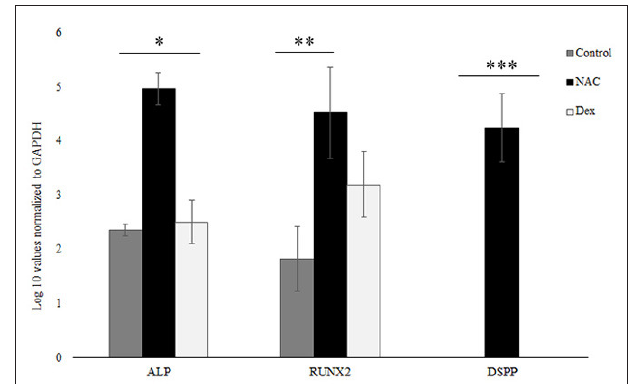
FIGURE 4 | NAC upregulated ALP, RUNX-2, and DSPP. NAC treated upregulated the levels of various odontoblastic genes like ALP, RUNX-2, and DSPP. These values were normalized to the housekeeping gene GAPDH, and the log 10 values are shown here. The NAC treated cells had significantly higher expression levels of these genes as compared to the control cells. The gene expression levels similar for RUNX-2 between the NAC and Dex groups but statistically different for the ALP and the DSPP genes (*, **, *** p <